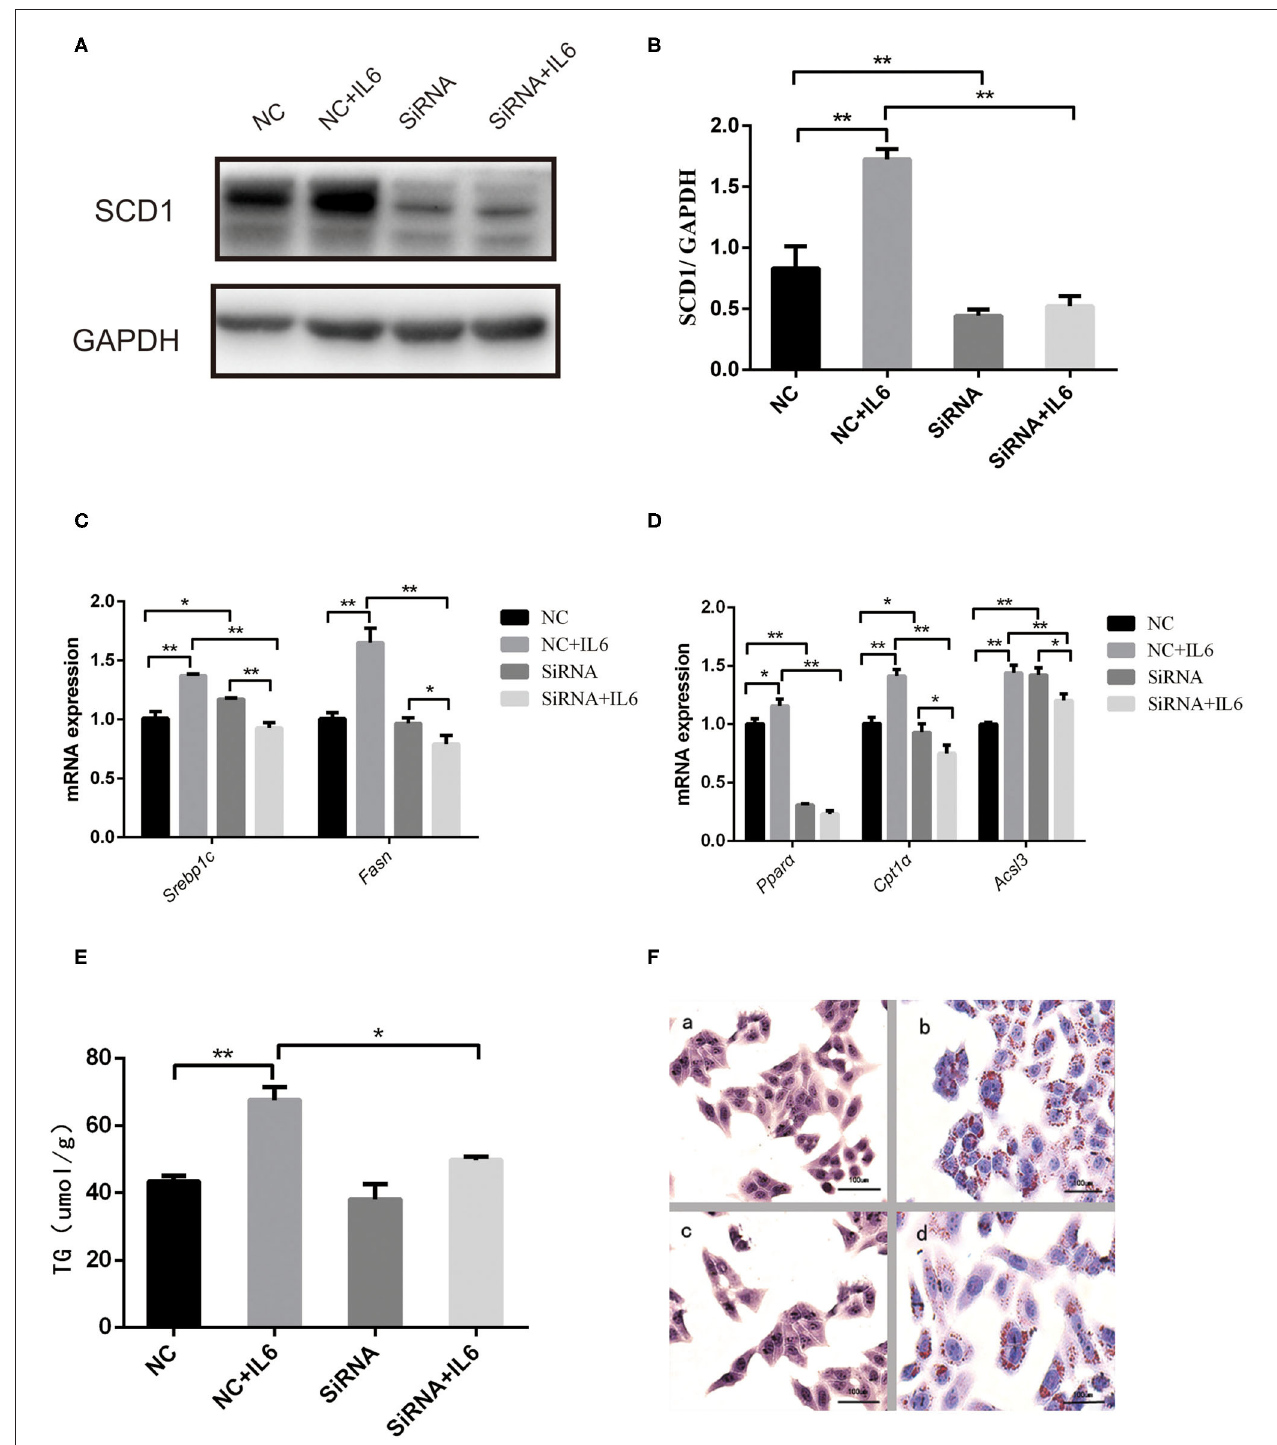
FIGURE 5 | Scd1 knockdown alleviates the lipid accumulation in HepG2 cells exposed to rIL6. (A) Determination of SCD1 protein levels upon siRNA interference in HepG2 cells with or without rIL6 treatment in vitro . (B) Quantitative comparison of SCD1 protein levels in HepG2 cells upon siRNA knockdown with or without rIL6 treatment in vitro . (C–E) Quantitative comparison of mRNA levels of genes related to lipid synthesis (C) and lipid oxidation (D) and intracellular TG levels (E) in HepG2 cells upon siRNA knockdown with or without rIL6 treatment in vitro . (F) Oil red O staining of HepG2 cells. (a): Negative control (NC) group; (b): NC + IL6 group; (c): siRNA group; (d): siRNA + IL6 group. ** P < 0.01; * P < 0.05.